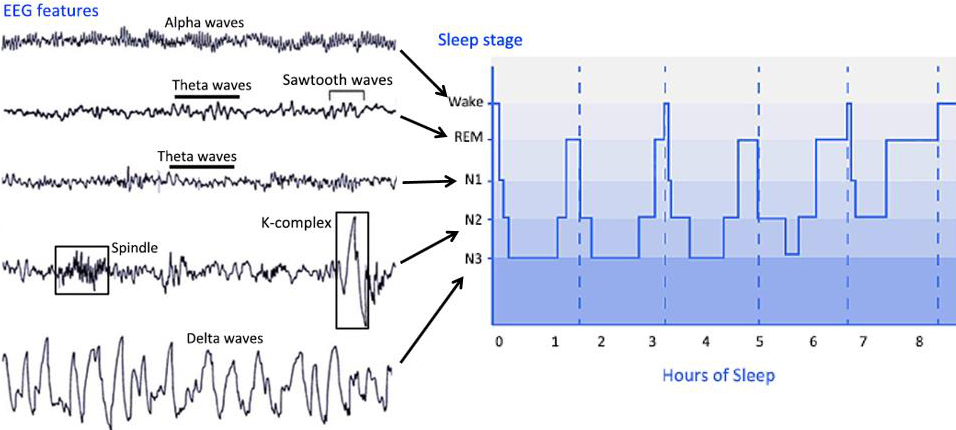
Figure 2. EEG features and hypnogram of sleep stages. The right side of the figure is a hypnogram, which describes the different sleep stages of 8 h of sleep at night. The EEG characteristics of each sleep stage are listed on the left. Abbreviations: REM, rapid eye movement sleep; N1, non-REM sleep stage 1; N2, non-REM sleep stage 2; N3, non-REM sleep stage 3.